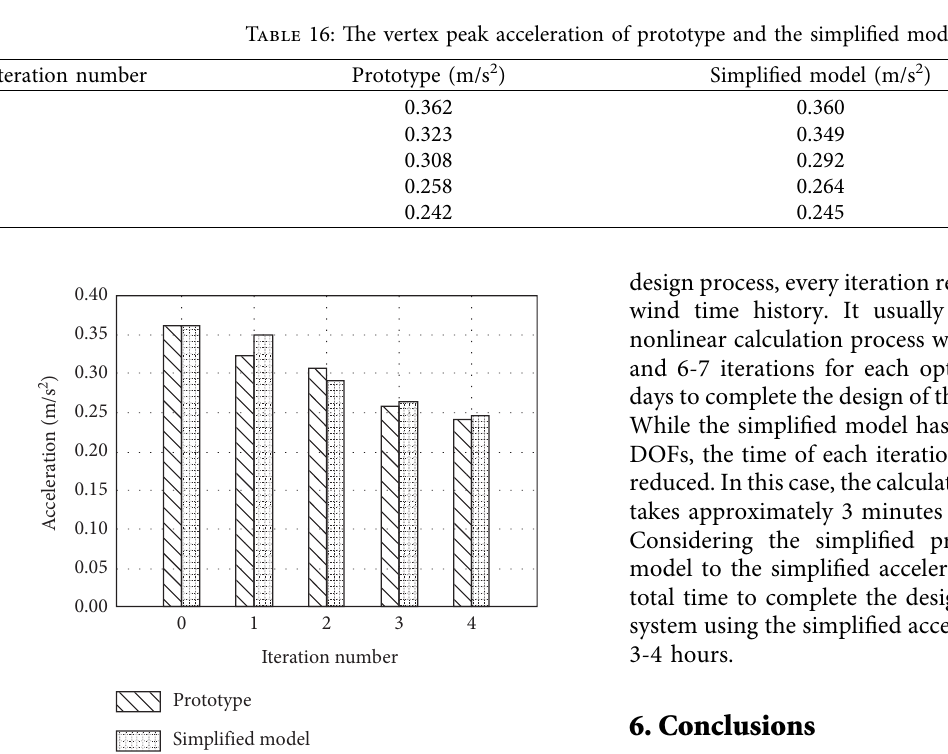
Figure 27: The vertex peak acceleration of prototype and simplified